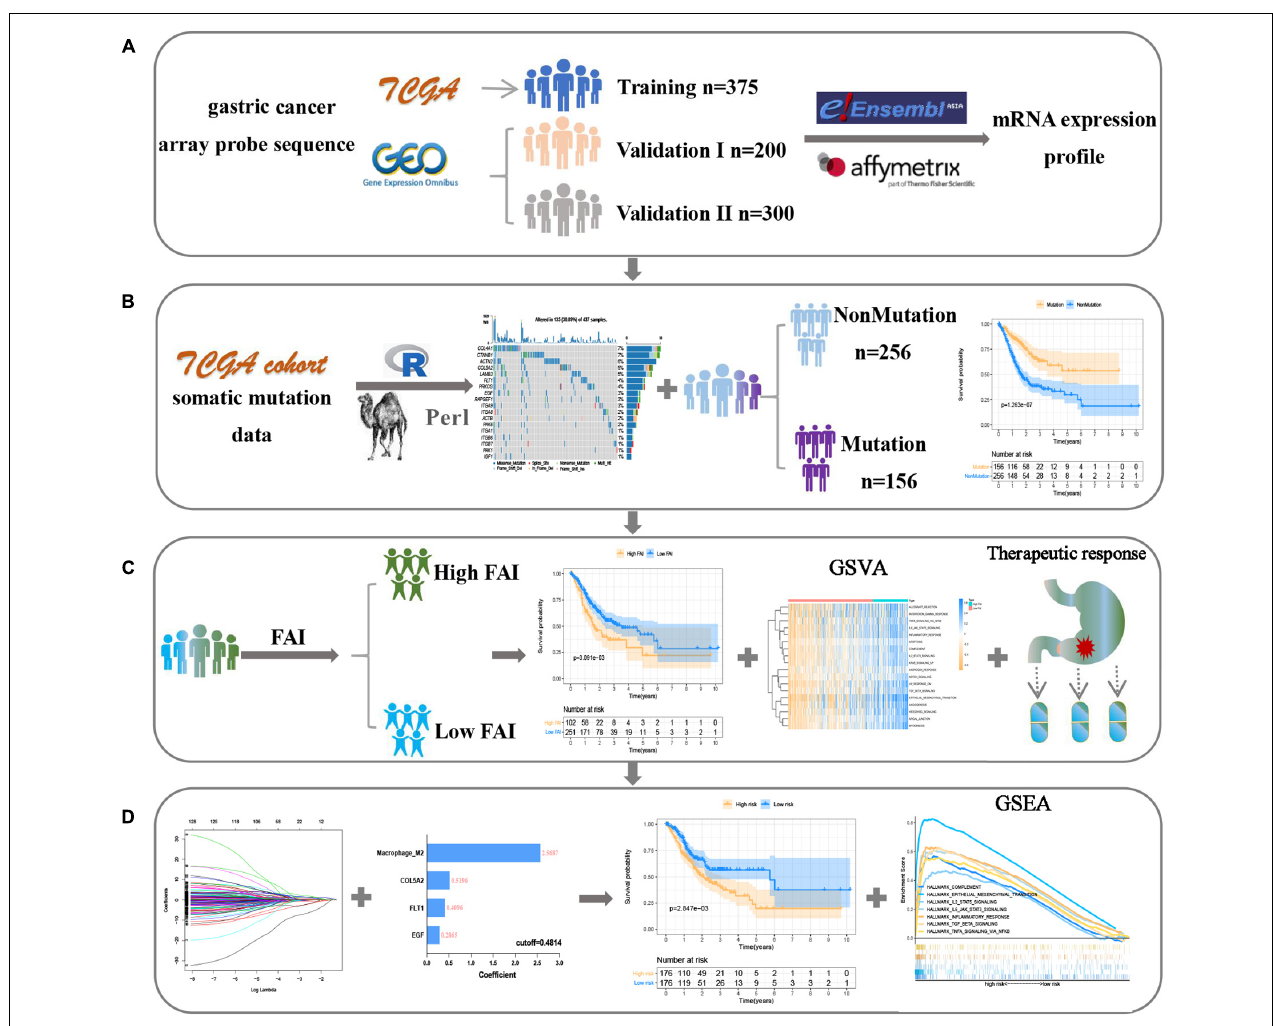
FIGURE 1 | The flow chart shows the process of this work. (A) Data acquisition and processing. (B) Explore focal adhesion mutation type. (C) The establishment of FAI is based on the expression of focal adhesion-related genes. (D) Development and verification of the prognostic